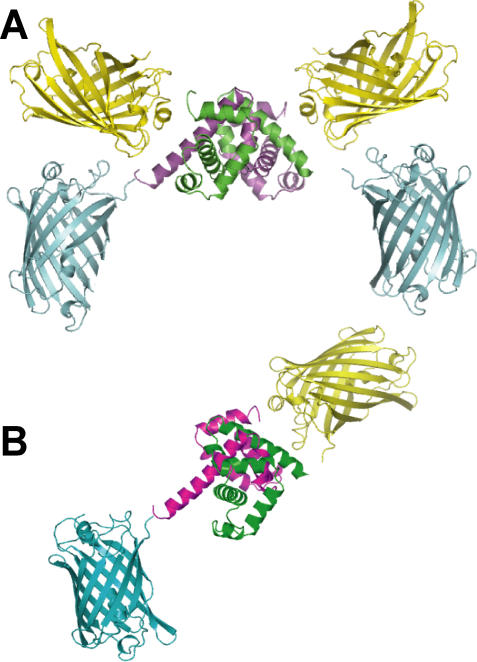
Structural Models of FLIPW-CTY and FLIPW-CTYT Tryptophan SensorsTrpR: green, magenta, eCFP: blue, and Venus: yellow. (A) Dimer of two FLIPW-CTY chains resulting in a TrpR dimer that can bind tryptophan. (B) FLIPW-CTYT monomer. The relative positions of the fluorophore proteins with respect to the TrpR dimer are speculative.